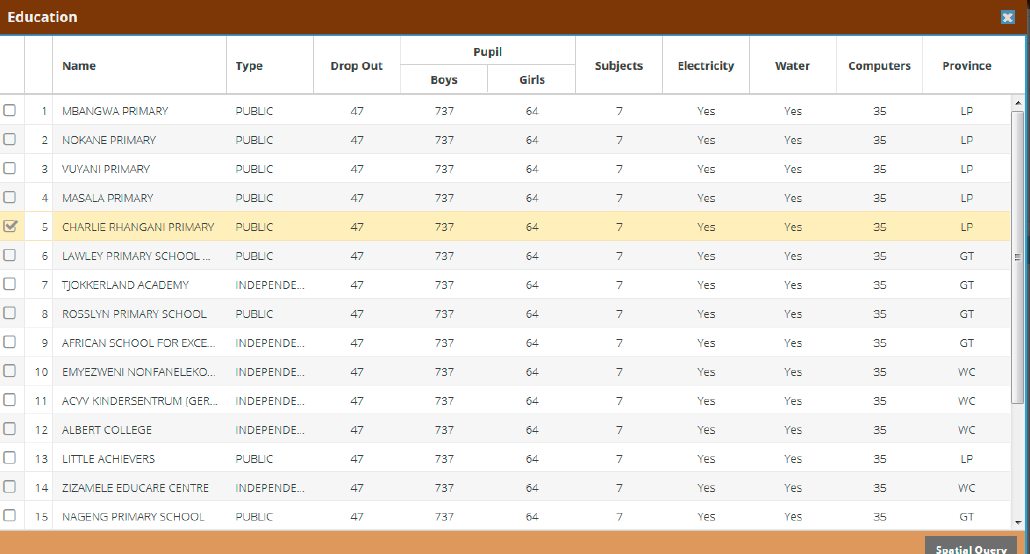
Figure 20. Spatial querying capability.